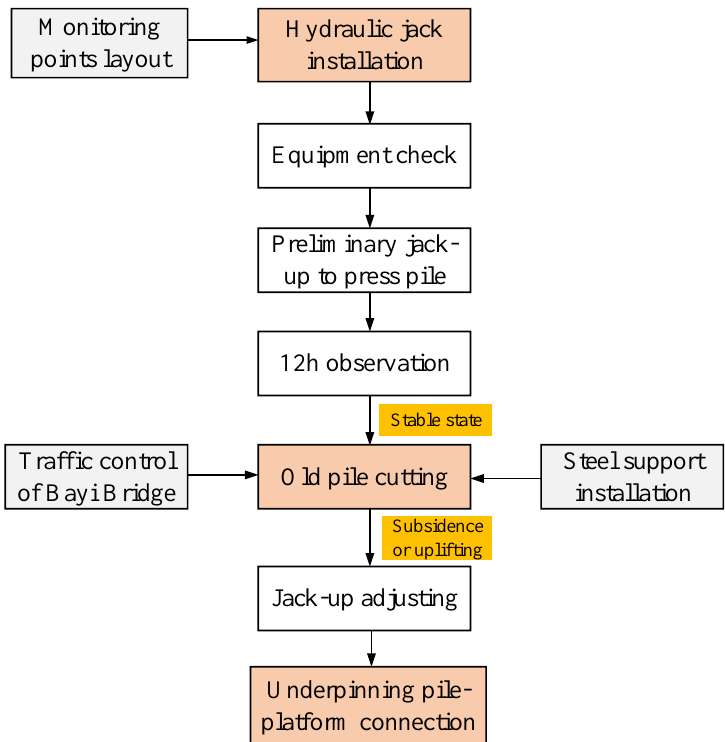
Figure 3. Construction process of underpinning pile foundation.